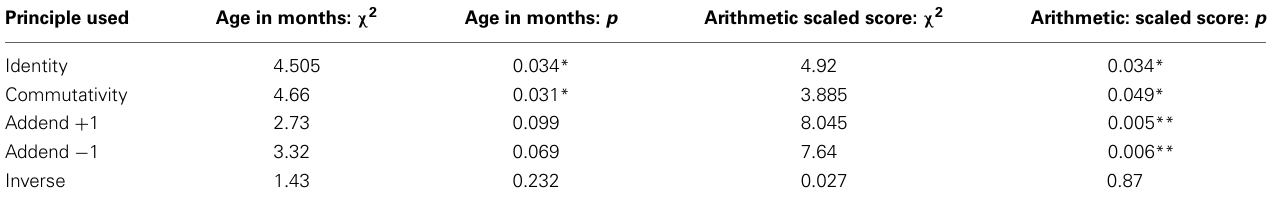
Table 2 | Results of nominal logistic regressions on the use of addition strategies with age and arithmetic scaled score as covariates. Principle used